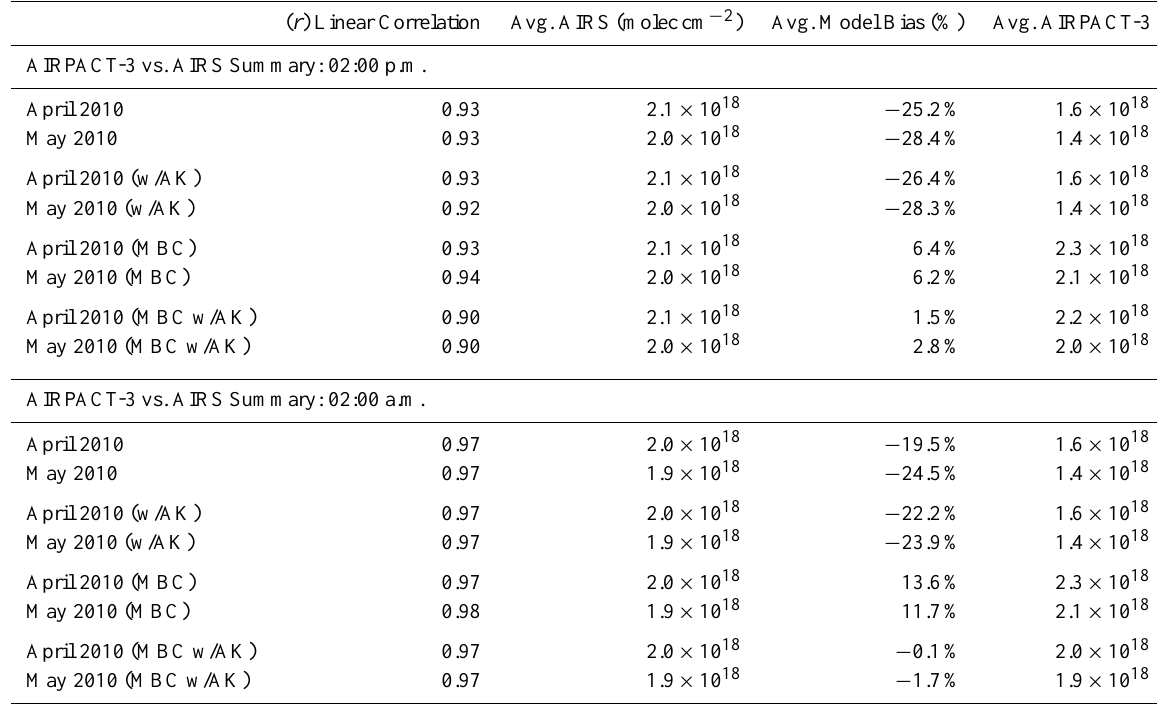
Table 1. Summary of 02:00 p.m. (top) and 02:00 a.m. (bottom) carbon monoxide VCD for AIRPACT-3 vs. AIRS (All times are in Pacific Standard Time).